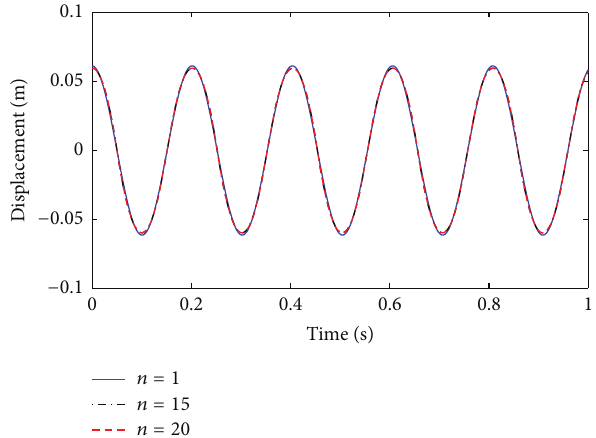
Figure 2: Displacements under the residue of singularities 𝑠 𝑛 for various order values of 𝑛 at the transport speed V = 1 m / s.